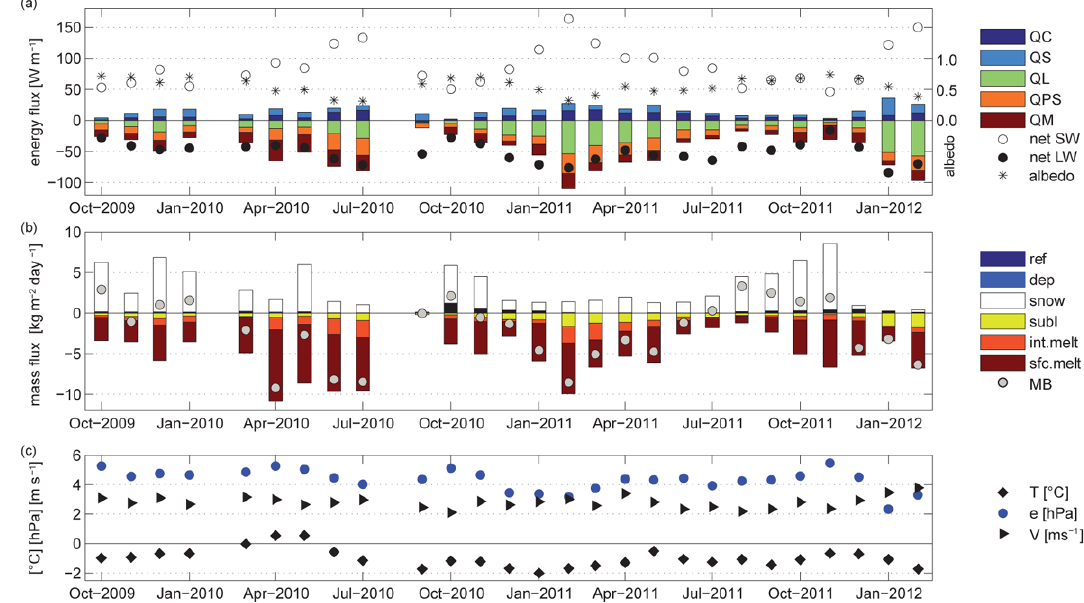
Fig. 5. (a) Monthly mean energy flux density of net shortwave radiation (net SW), net longwave radiation (net LW), conductive energy flux (QC), turbulent sensible energy (QS), turbulent latent energy (QL), penetrating shortwave radiation (QPS), energy for melting (QM) and surface albedo at Lewis Glacier AWS (4828m). (b) Monthly mean mass flux rate of refreezing (ref), surface deposition (dep), solid precipitation (snow), sublimation (subl) internal melt (int.melt), surface melt (sfc.melt) and net mass balance rates (MB). (c) Monthly means of air temperature ( T [ ◦ C]), vapor pressure ( e [hPa]) and wind speed ( V [ms − 1